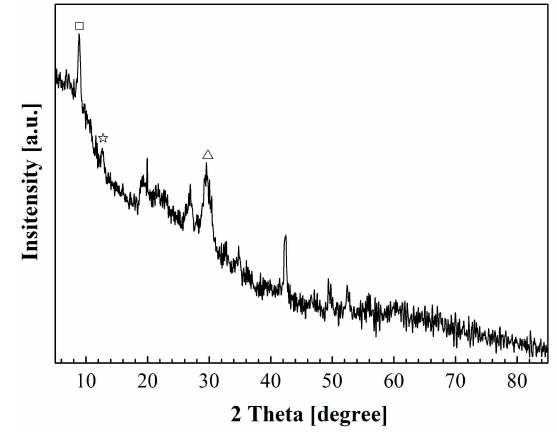
Figure 3. X-ray diffraction (XRD) pattern of Cu 3 (PO 4 ) 2 nanoflower.